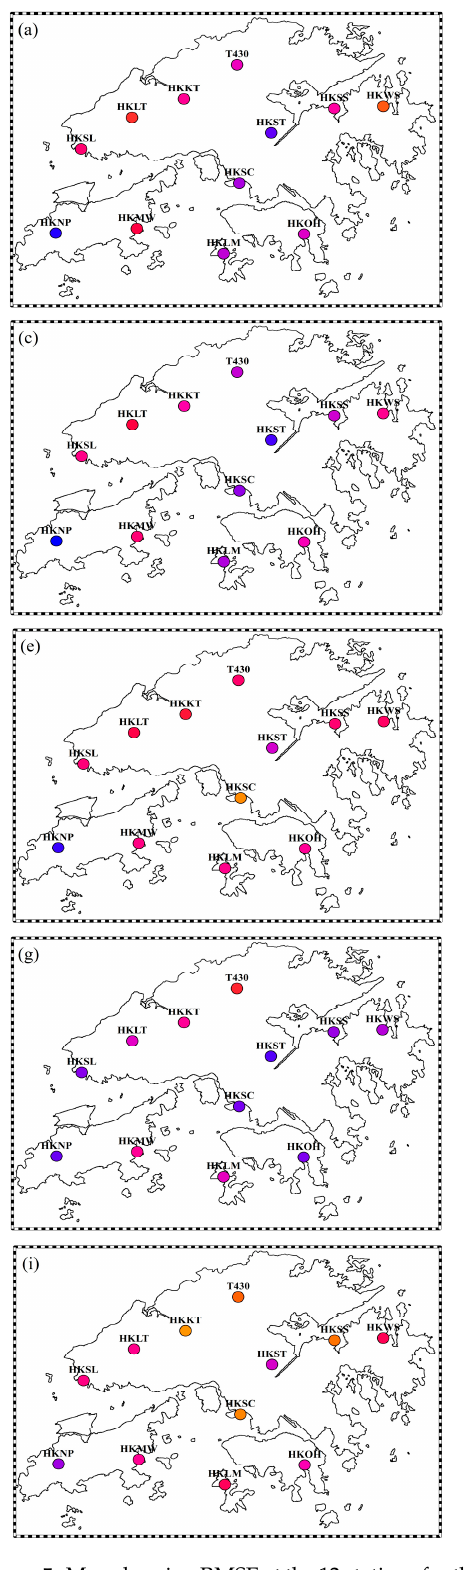
Figure 5. Map showing RMSE at the 12 stations for the 10 interpolation schemes in rainy weather condition. ( a ) IDW, ( b ) IDW-GPT2w, ( c ) Kriging, ( d ) Kriging-GPT2w, ( e ) 3DKriging, ( f ) 3DKriging-GPT2w, ( g ) TPS, ( h ) TPS-GPT2w, ( i ) 3DTPS, ( j ) 3DTPS-GPT2w.